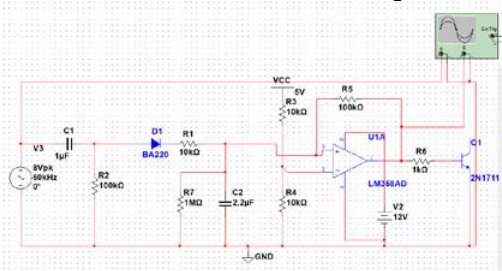
Fig. 3. Short circuit protection simulation